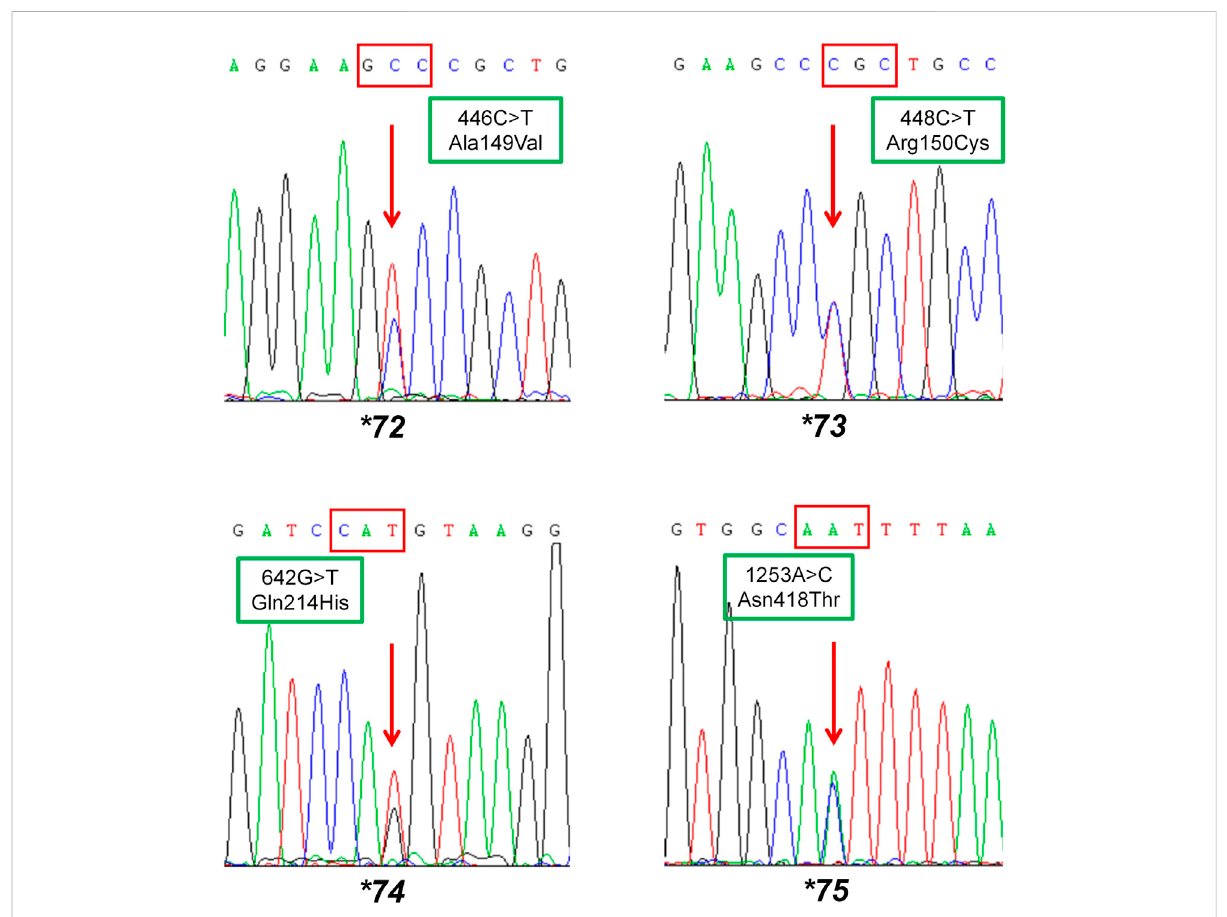
FIGURE 2 Sequencing results ofthecarriers with newly designated alleles CYP2C9*72 , CYP2C9*73 , CYP2C9*74 and CYP2C9*75 . Thered arrowindicates mutated sites in allelic variants CYP2C9*72 - *75 . Rectangular boxes show the cDNA mutations and the amino acid substitutions at codon 149, 150, 214 and 418, respectively.